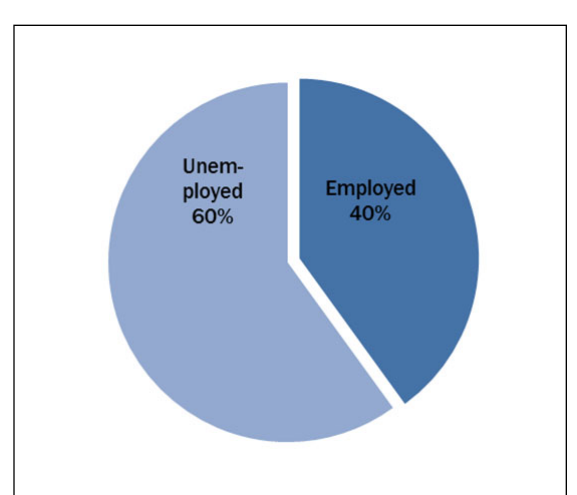
Figure 1. Gender Distribution in the Practice of Urban Agriculture (N=30)